Question: Does the figure show an increasing or a decreasing trend?
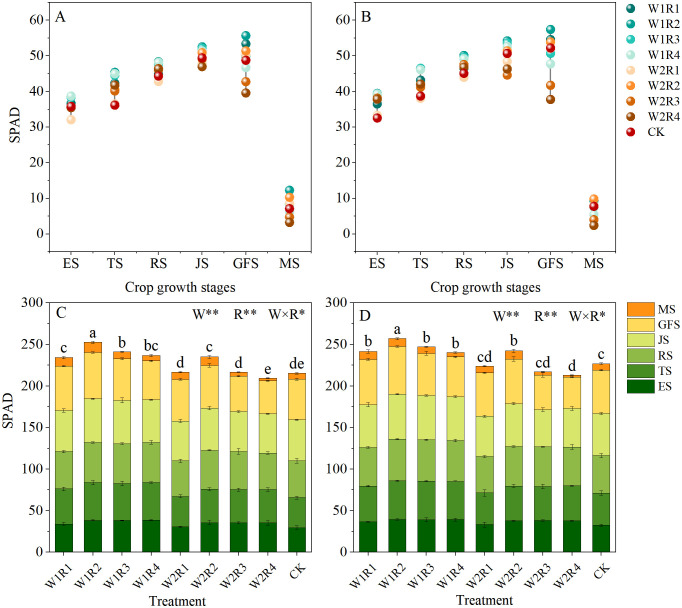
Answer: increasing